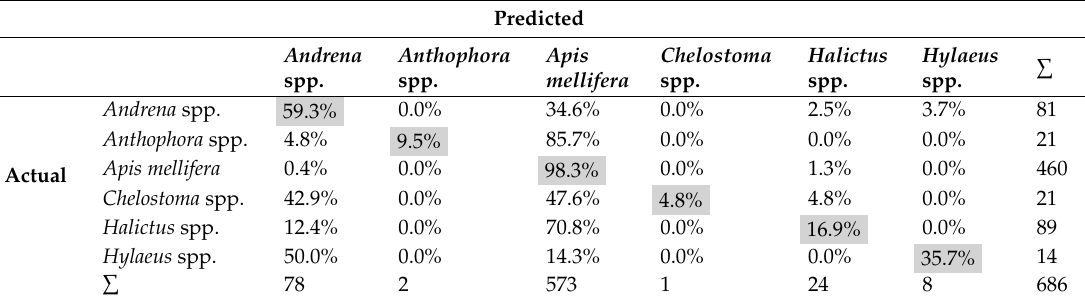
Table 2. Confusion matrices summarizing the percentages of visitors correctly identified by the random forest models (shaded diagonals), and the frequencies of misidentifications. Tables 2 and 3, respectively, summarize models with only shape-related or only phenology-related explanatory